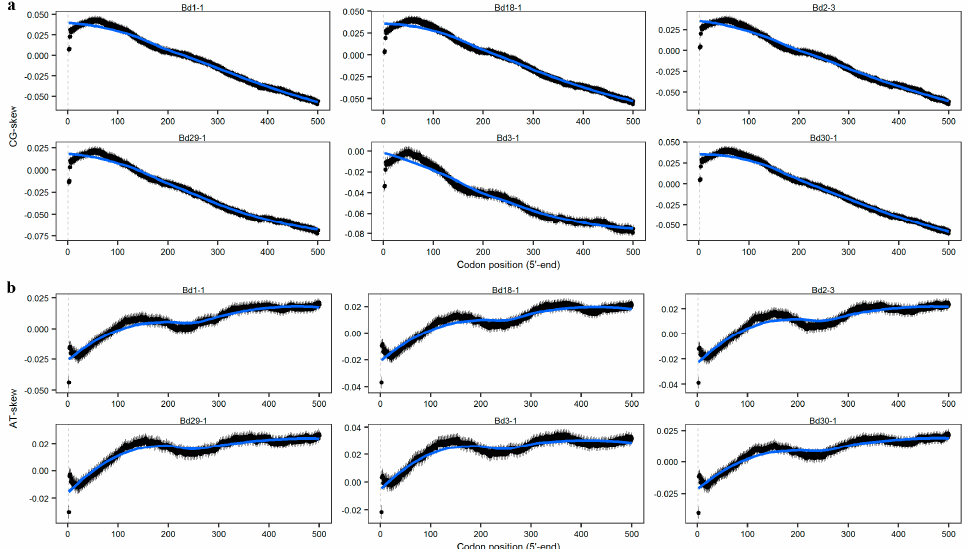
Figure 7. The relationships between both CG- and AT-skews and codon position. ( a ) CG-skews of nucleotides at the 5 ′ -ends of the CDSs in the six lines; ( b ) AT-skews of nucleotides at the 5 ′ -ends of the CDSs in the six B. distachyon